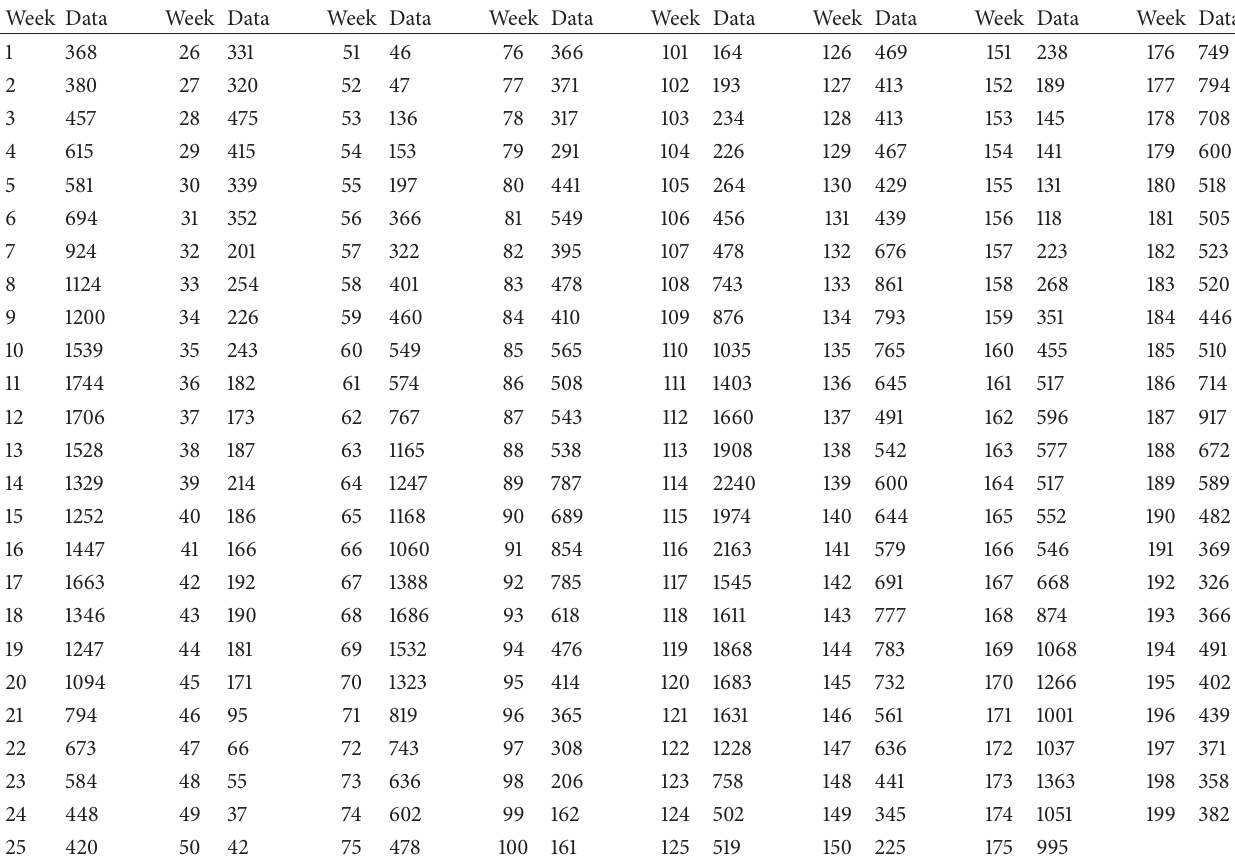
Table 1: The numbers of weekly reported HFMD cases in